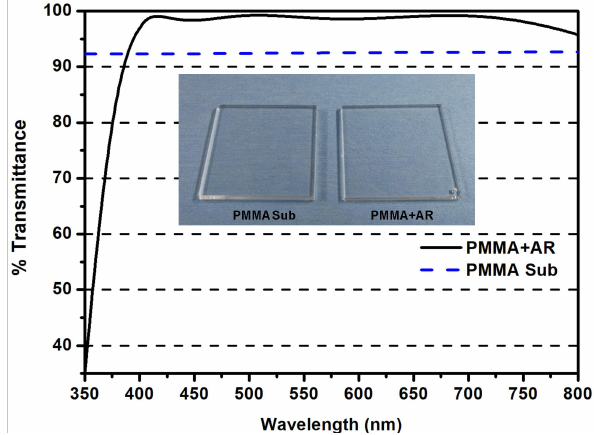
Figure 1. Transmittance of Polymethyl methacrylate (PMMA) substrate (blue line) and PMMA with two-side AR coatings (black line).